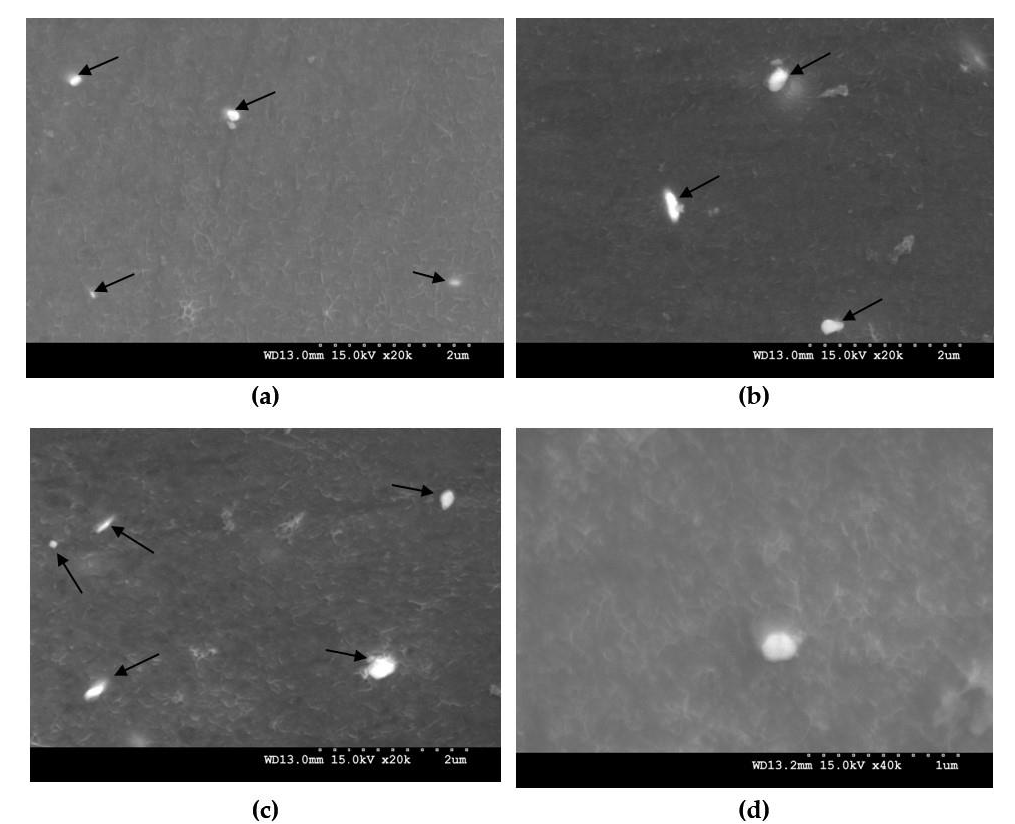
Figure 1. Scanning electron microscopy (SEM) images showing the distribution of Sm 2 O 3 nanoparticles (indicated by the arrows) in Mg-Sm 2 O 3 nanocomposites: ( a ) Mg-0.5 vol % Sm 2 O 3 ( b ) Mg-1 vol